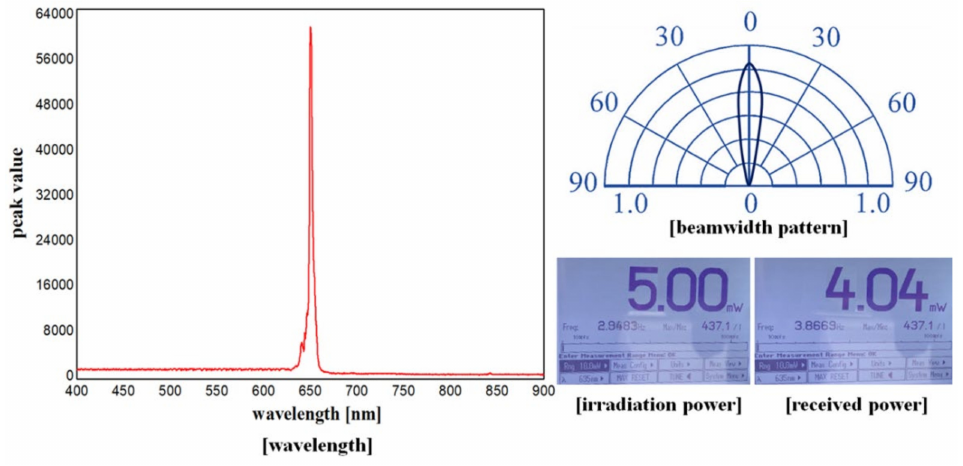
Figure 2. Characteristics of the laser module with its beam pattern